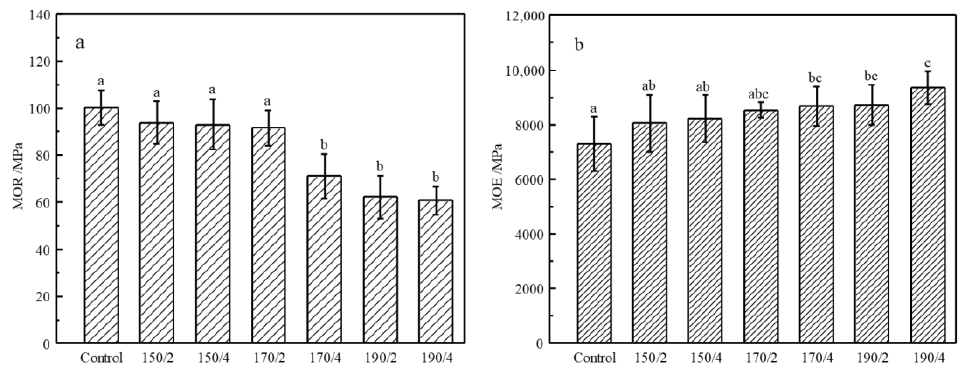
Figure 7. MOR ( a ) and MOE ( b ) of the control and HT wood. Bars with different letters indicate significant differences ( p < 0.05) according to Duncan’s multiple range tests.